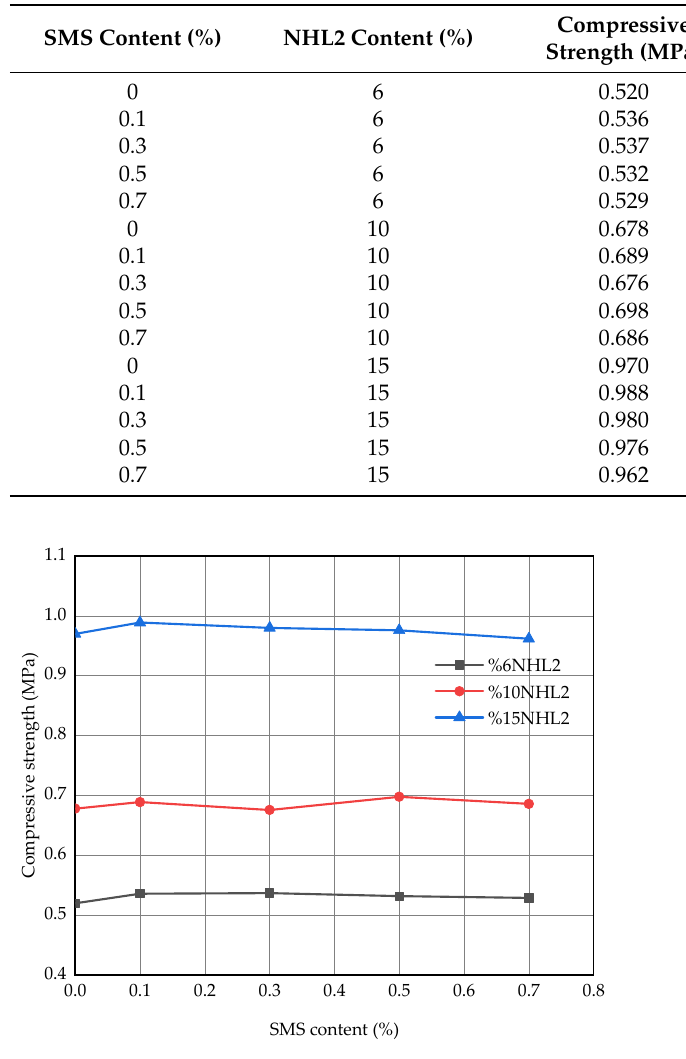
Figure 2. Compressive strength change curve.